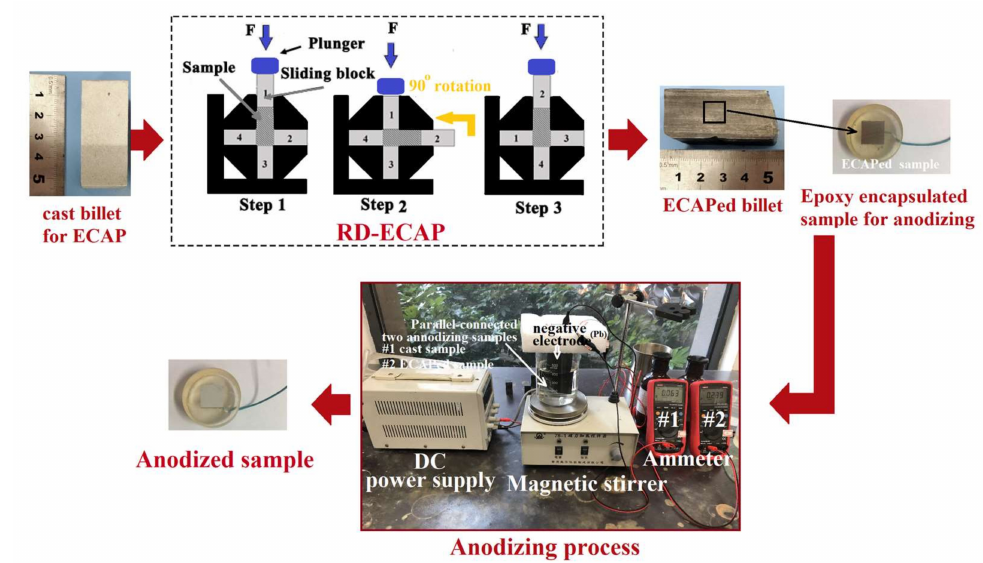
Figure 1. Combined Rotary-die (RD)-equal-channel angular pressing (ECAP) process and post-anodizing process of pure